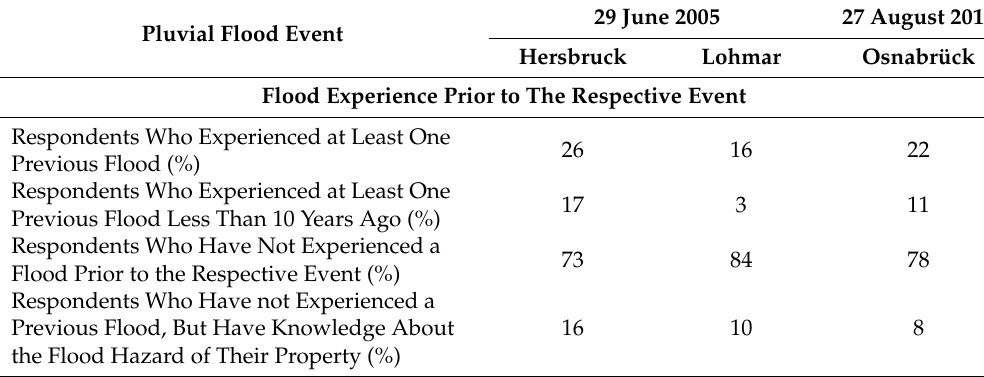
Table 2. Flood experience and knowledge about the flood hazard among private households in each study